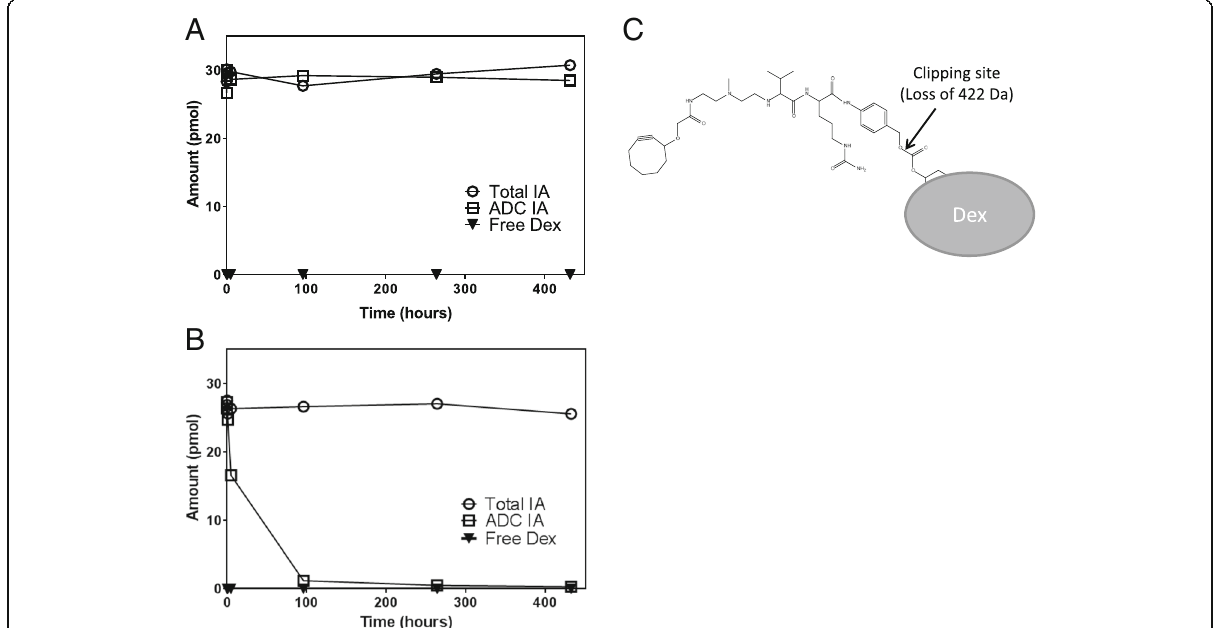
Fig. 2 In vitro stability of anti-CD25-Phos-Dex and anti-CD25-Cat-Dex in mouse plasma. To assess the trend in stability of these antibodies, Anti- CD25-Phos-Dex ( a ) or anti-CD25-Cat-Dex ( b ) was spiked in normal male DBA1 mouse plasma for up to 18 days at 37 °C. After incubation, the levels of antibody was determined by total antibody immunoassay (Total IA) and the levels of intact ADC was determined by ADC specific immunoassay (ADC IA) on plasma samples using Mesoscale Discovery (MSD) sandwich immunoassay, and free dexamethasone was determined by LC-MS (Free Dex). Amounts in picomole (pmol) versus time are plotted to compare across different methods of analysis. Values represent the results of a single incubation at each time point. Panel c shows the unexpected site of cleavage in the cathepsin linker of